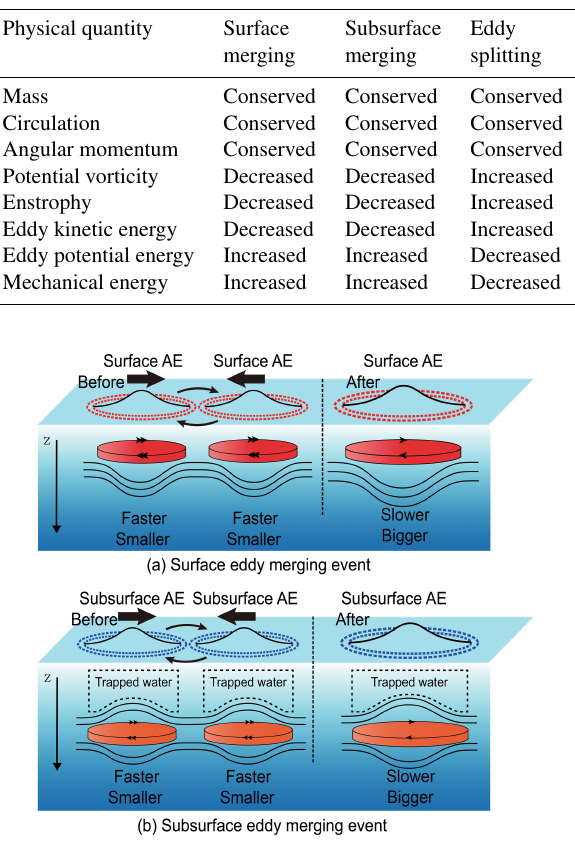
Figure 6. (a) Surface eddy merging event and (b) subsurface eddy merging